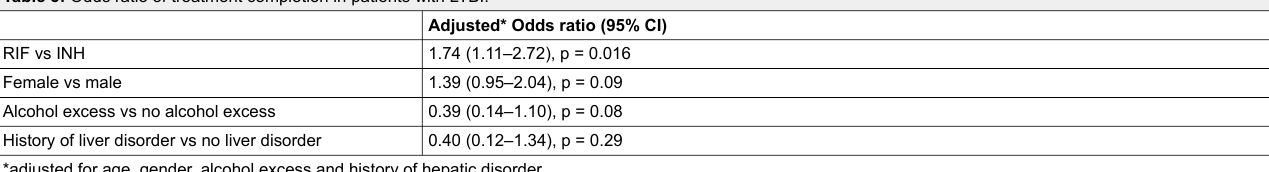
Table 3: Odds ratio of treatment completion in patients with